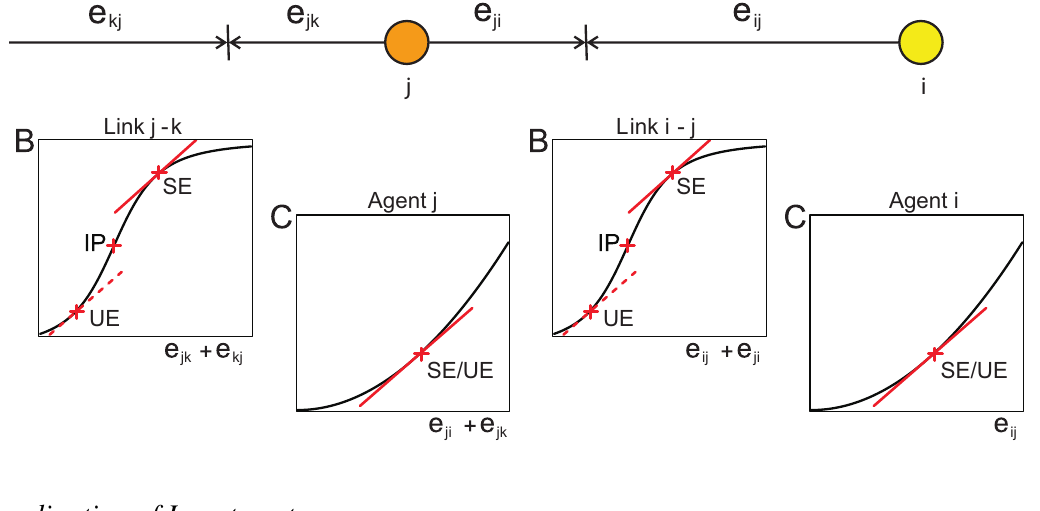
Figure 1. (Reprinted from [21]) Adjustment of investments. Shown are the perceived cost functions C and benefit functions B (insets) for the example of an agent i of degree one interacting with an agent j of degree two (sketched). The function B depends on the sum of the agents investments into the interaction while C depends on the sum of all investments of the agent. In every equilibrium (SE or UE) stationarity demands that the slope of these functions be identical. This requires that the agents make identical total investments. In stable equilibria (SE), the operating point lies in general above the inflection point (IP) of B , whereas equilibria found below the IP are in general unstable (UE). Therefore, in a stable equilibrium both links produce the same benefit and both agents make the same total investment. Iterating this argument along a sequence of bidirectional links yields the coordination properties (i) and